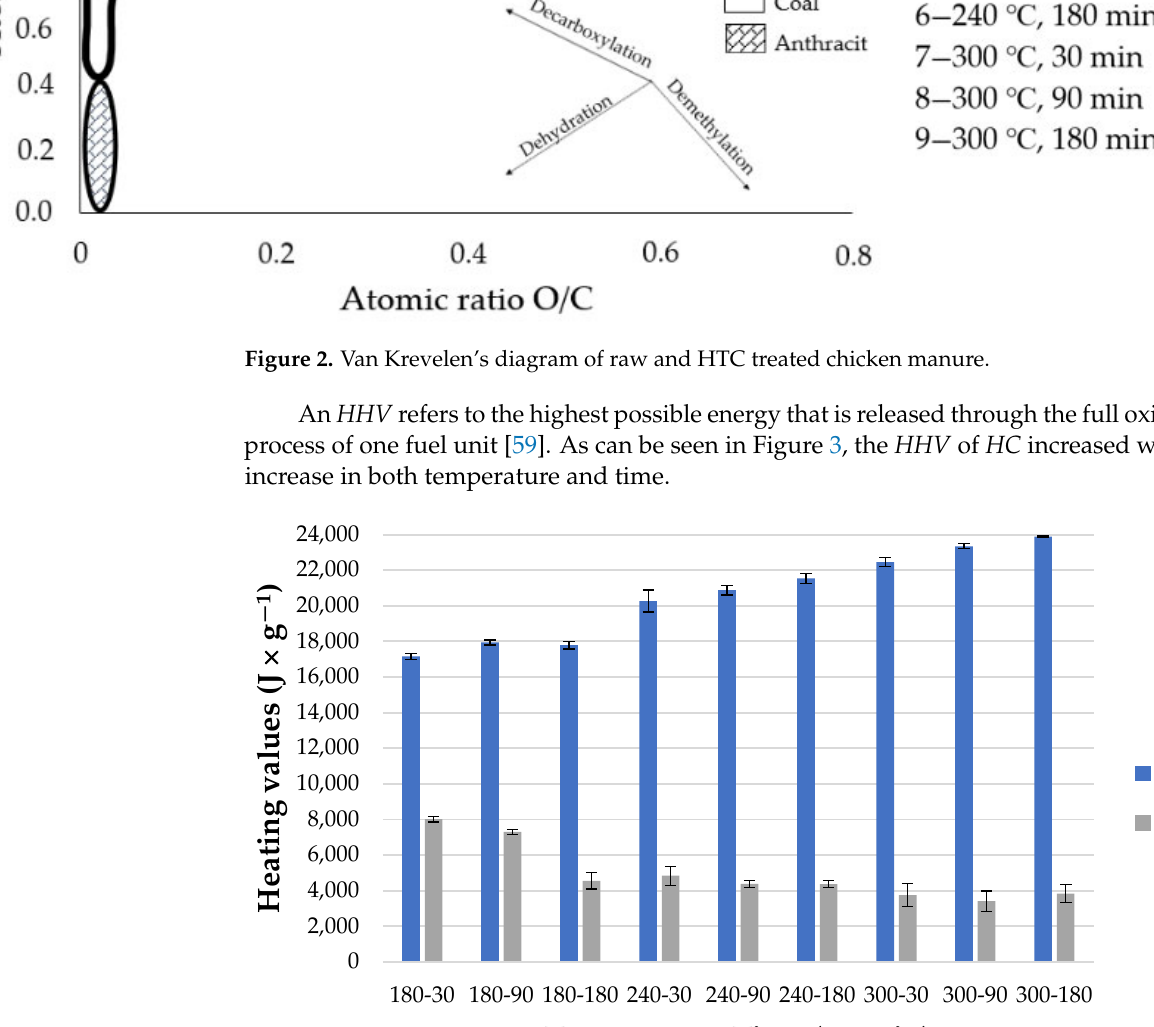
Figure 3. High and low heating value of hydrochars. The HC derived at 300 ◦ C in 180 min was characterized by the highest HHV (23,880.67 ± 34.56 J × g − 1 ). The difference between this HC and raw CM is ~8329 J × g − 1 . The difference in HHV was statistically significantly different ( p < 0.05) (Table A4). HTC of CM led to the production of fuel with relatively high HHV , as lignite is characterized by an HHV of ~30 MJ × kg − 1 [48]. What is more, this value is similar to HC s obtained from some other types of biomass. For instance, grape pomace converted at 300 ◦ C in 30 min reached an HHV of 25.29 MJ × kg − 1 , and corn stover carbonized at 300 C in 77 min reached an HHV of 27,470.00 J × g − 1 . The obtained result is also higher when compared to wood materials. For instance, spruce wood and beech wood were characterized by 20.4 and 19.3 MJ × kg − 1 , respectively [60]. The LHV value, which allows for determining the actual energy potential of biomass [61], decreased with higher parameters of the HTC process (Figure 2), which is related to the amount of solid phase obtained during the process. The LHV decreased from 8,030.10 ± 494.63 J × g − 1 (180 C ‐ 30 min) to 3,410.45 ± 570.11 J × g − 1 for HC obtained at 300 C in 90 min. What is more, the LHV value was higher for HC obtained at 180 and 240 C than raw chicken manure (4232.89 ± 367.20 J × g − 1 ), whereas the LHV of HC obtained at 300 C was lower. 3.3. Hydrochar and HTC Energy Yields Figure 4 shows an example of temperatures and pressure patterns during the HTC process. The average heating rate was ~4.9, ~4.0, and ~3.8 C × min − 1 for 180, 240, and 300 C, respectively.